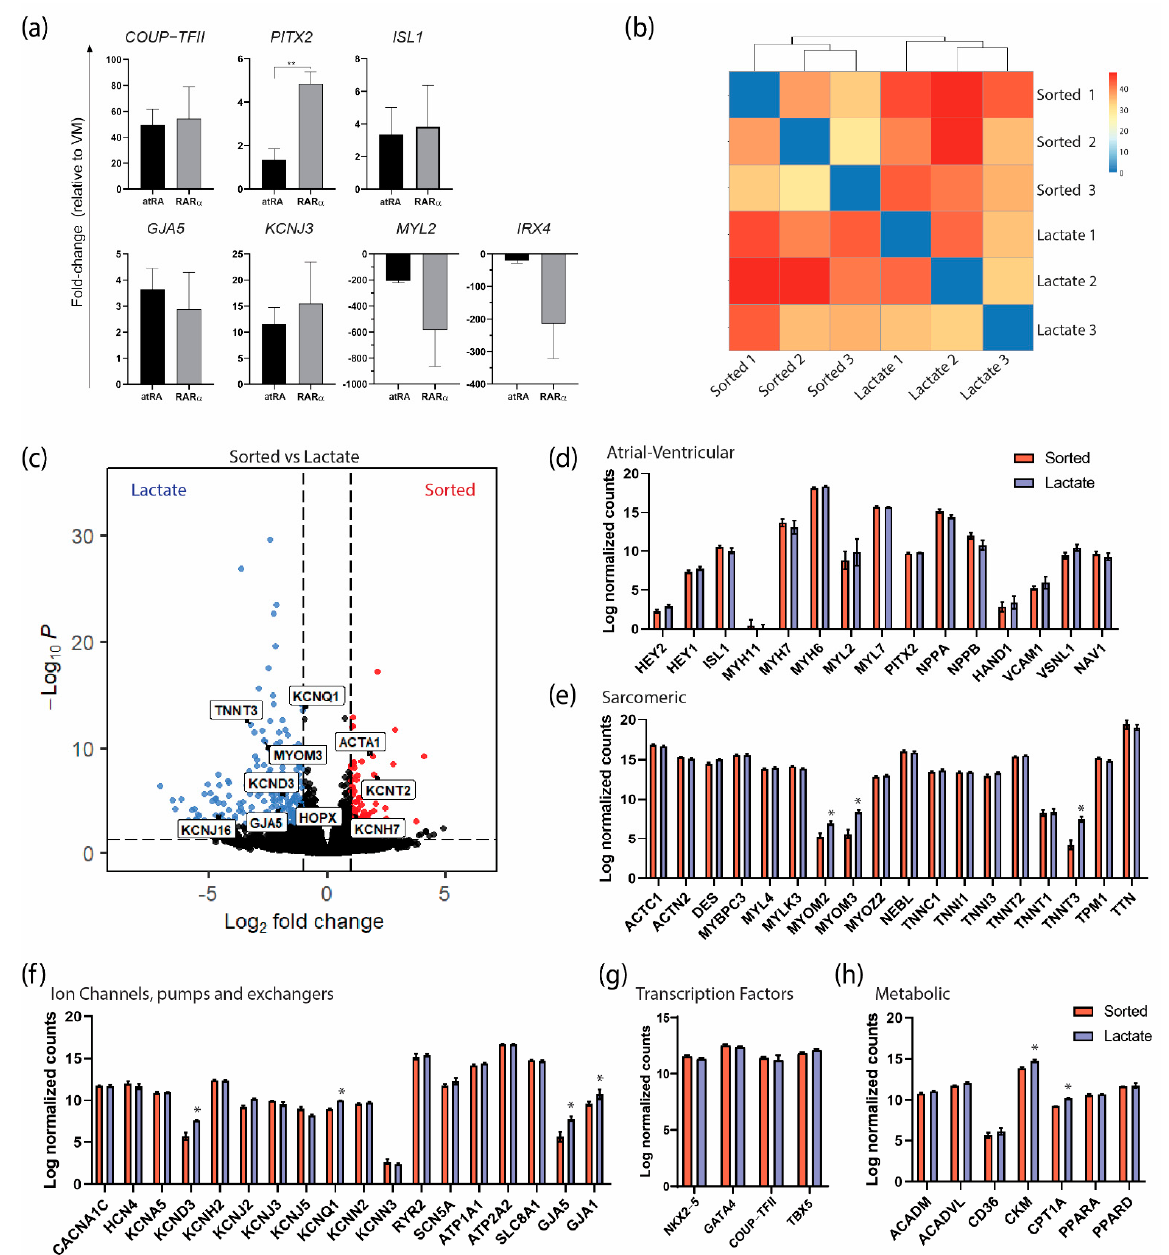
Figure 5. Transcriptional characterization of atRA and RAR α COUP − Red AMs by RNAseq and RT − qPCR. ( a ) Transcriptional profiling of selected atrial-specific genes by qPCR in G + /M + cells from atRA or RAR α protocol relative to expression in ventricular cardiomyocytes (VM). ** p < 0.01. Data shown as means ± S.E.M. Significance determined with unpaired t-test (n = 3 biological replicates per condition). ( b ) Expression heatmap of sample-to-sample distances on the matrix of variance-stabilized data for overall gene expression (n = 3 biological replicates per condition). ( c ) Volcano plot of gene expression in sorted vs. lactate AMs. Genes of interest are labeled. ( d − h ) Expression of genes (log-transformed normalized counts) predominant in atrial or ventricular cardiomyocytes ( d ), encoding for cardiac sarcomeric proteins ( e ), ion channels, pumps and exchangers ( f ) , and transcription factors ( g ) and involved in energy metabolism ( h ). Means shown with error bars indicating S.E.M. * p < 0.05, two-way ANOVA.